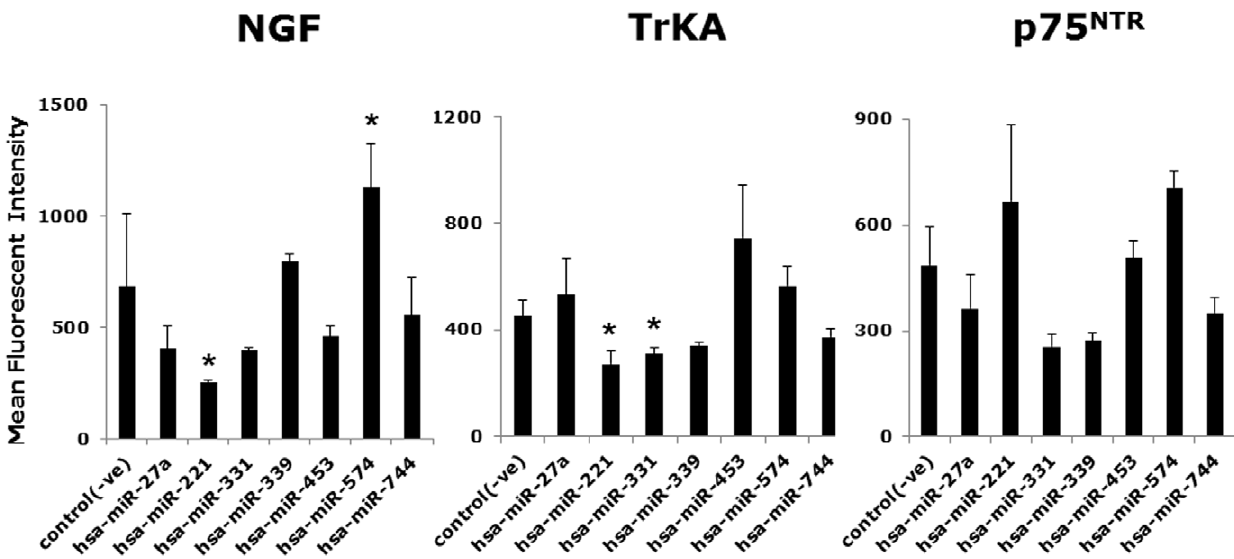
Figure 3. Flow cytometry of bronchial cells transfected with microRNAs. Consistent with the gene expression data, miR-221 transfection was associated to maximal downregulation of NGF protein synthesis, and was also associated to maximal downregulation of its high-affinity TrKA receptor. Data are expressed as the mean 6 SEM. Geometric mean fluorescent intensity (MFI) was averaged from the flow cytometry measurements obtained in 3 or 4 independent experiments. *=p , 0.01 compared to cells transfected with the negative control miRNA [control(-ve)].